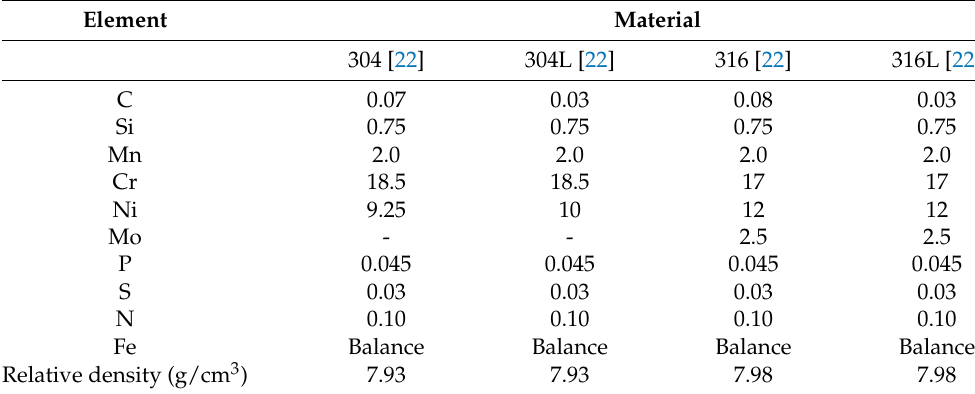
Table 1. Elemental composition by relative weight and relative density of the stainless-steel materials used in this